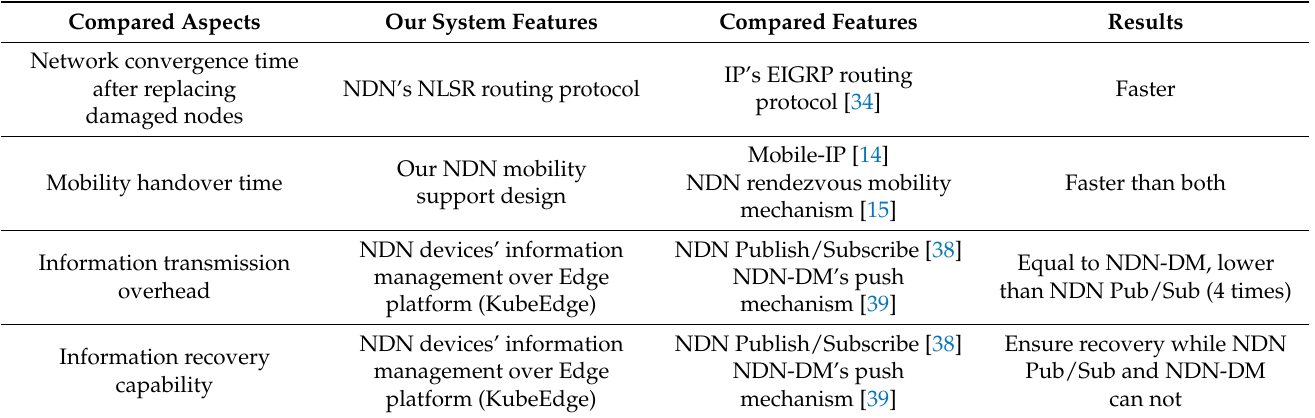
Table 3. Our system aggregated